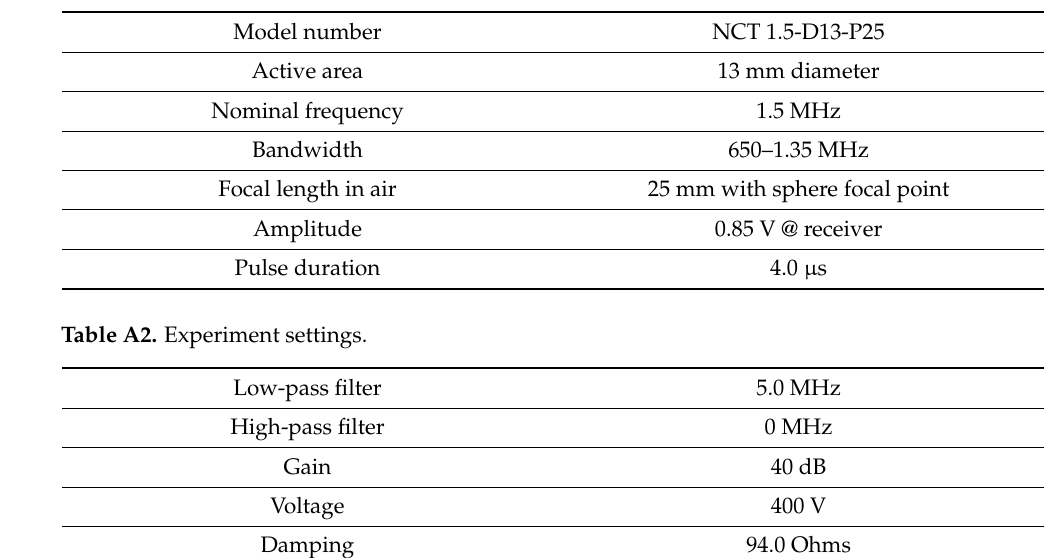
Table A1. Transducer information from datasheet.